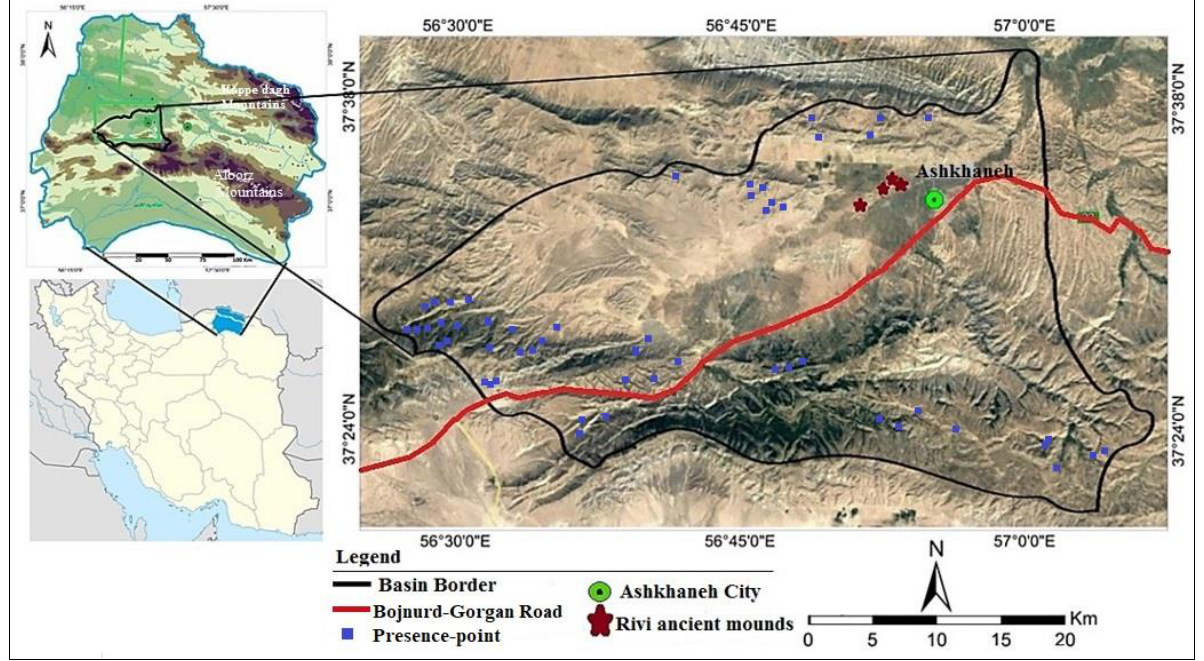
Figure 1. Location of the study area in